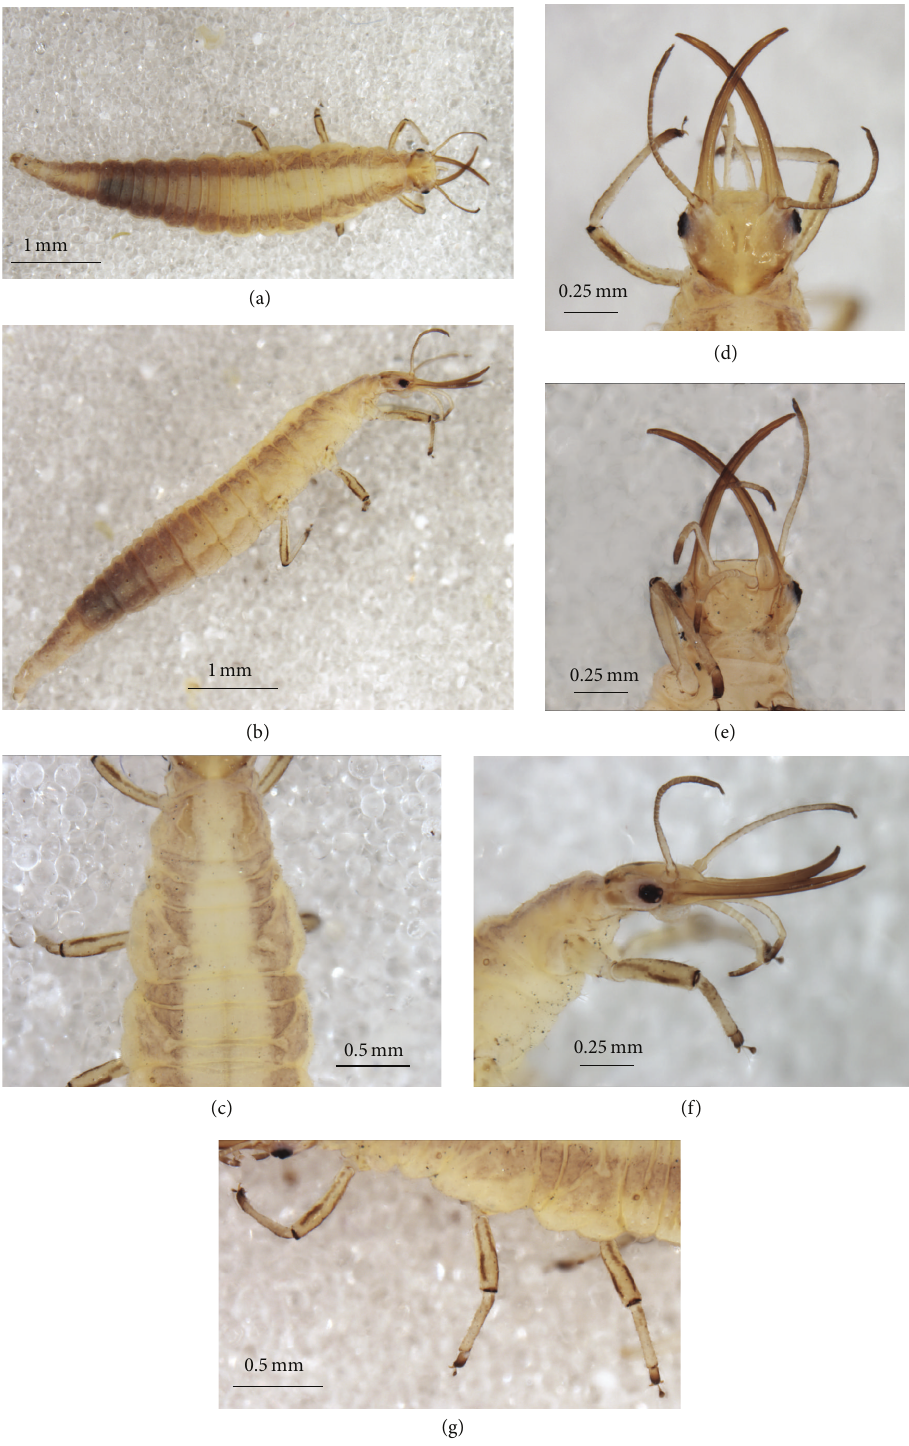
Figure 1: Hypochrysa africana Kimmins, second instar (Hoek-se-Berg Pass, South Africa). (a) Body, dorsal. (b) Body, lateral. (c) Thorax, dorsal. (d) Head, dorsal. (e) Head, ventral. (f) Head, lateral. (g) Legs,